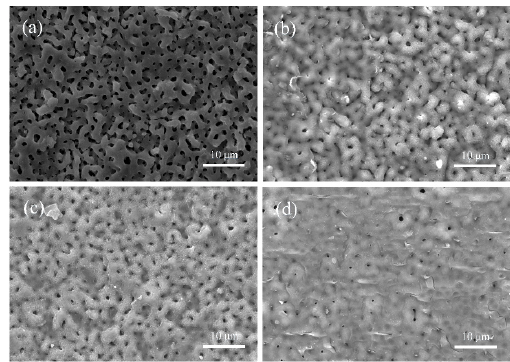
Figure 1. Scanning electron microscopy (SEM) cross-sectional morphologies of various coatings: ( a ) ultrasonic micro-arc oxidation (UMAO); ( b ) UMAO/polylactic acid and glycolic acid copolymer (PLGA)/berberine (BR)1.5; ( c ) UMAO/PLGA/BR3.0; ( d ) UMAO/PLGA/BR6.0.